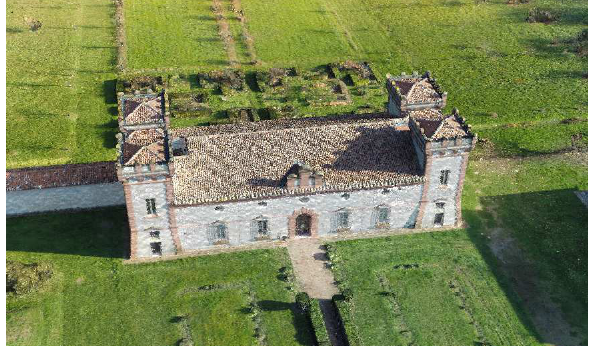
Figure 23: Point clouds obtained using fisheye release (dataset